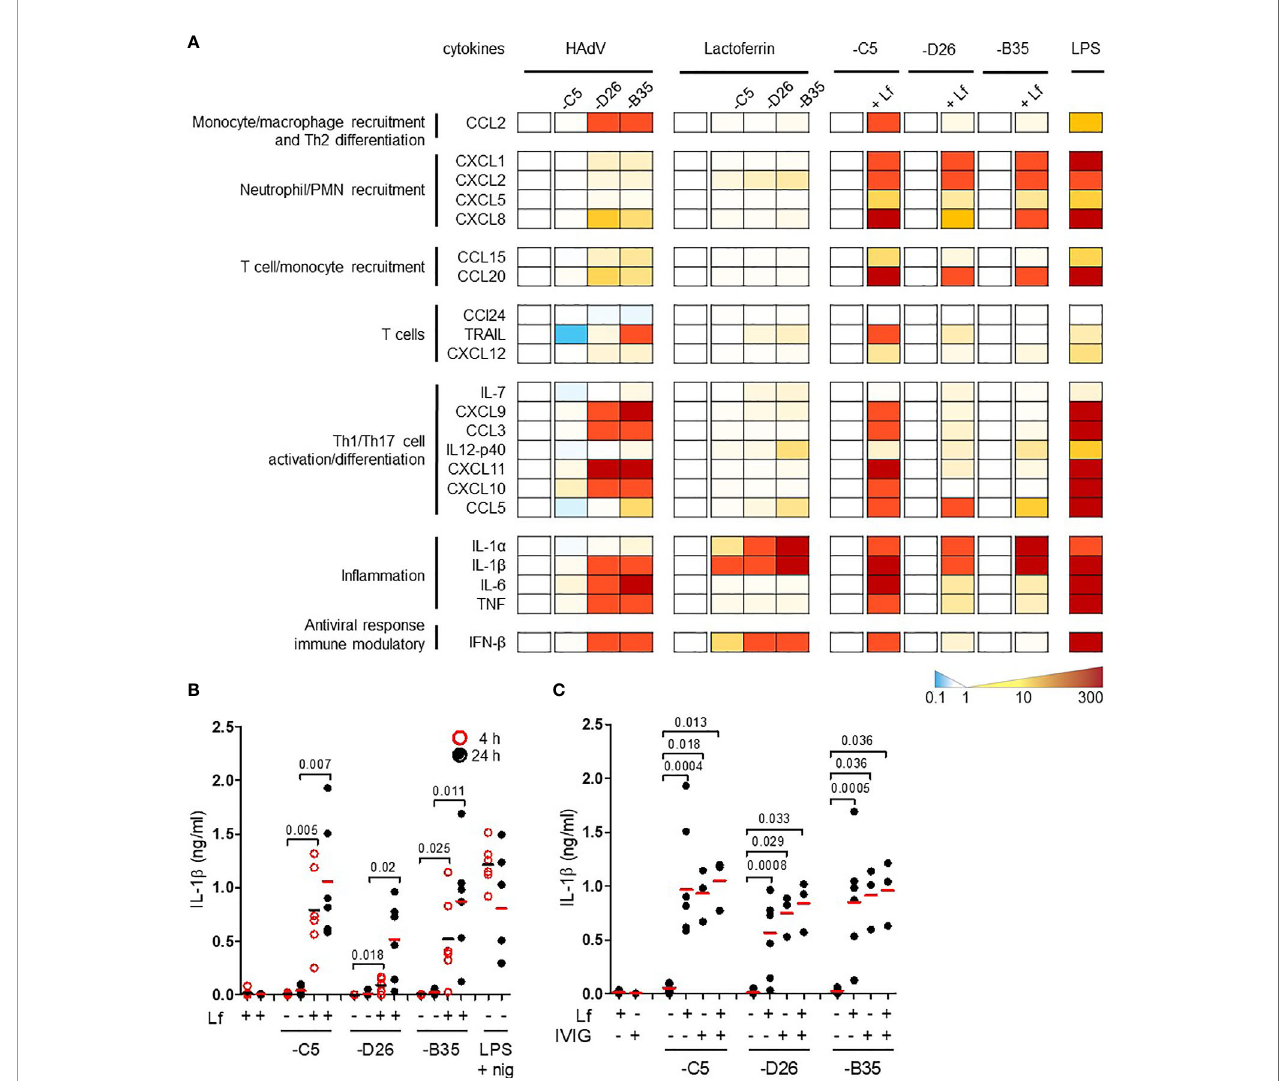
FIGURE 2 | HAdV-lactoferrin complexes induce IL-1 a and IL-1 b . (A) DCs were incubated with HAdV-C5, -D26, or -B35 ± lactoferrin for 4 h and cytokine secretion in supernatants was assessed by Luminex. To the left of each set of columns is the baseline reference set at zero. For the 4 columns on the left (HAdV), the baseline is mock-infected cells; for the middle columns (Lactoferrin) the baseline reference is lactoferrin-treated cells; for the “ paired ” columns on the right (-C5, -D26, and -B35) the reference is HAdV-infected cells compared to HAdV-lactoferrin infected cells. Raw data can be found in Figures S2A, B . LPS was used as a control; (B) IL-1 b release by DCs in the presence of HAdV-C5, -D26, and -B35 ± lactoferrin was assessed by ELISA at 4 (red circles) and 24 h (black dots) post-incubation (n = 6, statistical analyses by two-tailed paired t-test). As a control, cells were treated with LPS and nigericin; (C) DCs were incubated with HAdV complexed